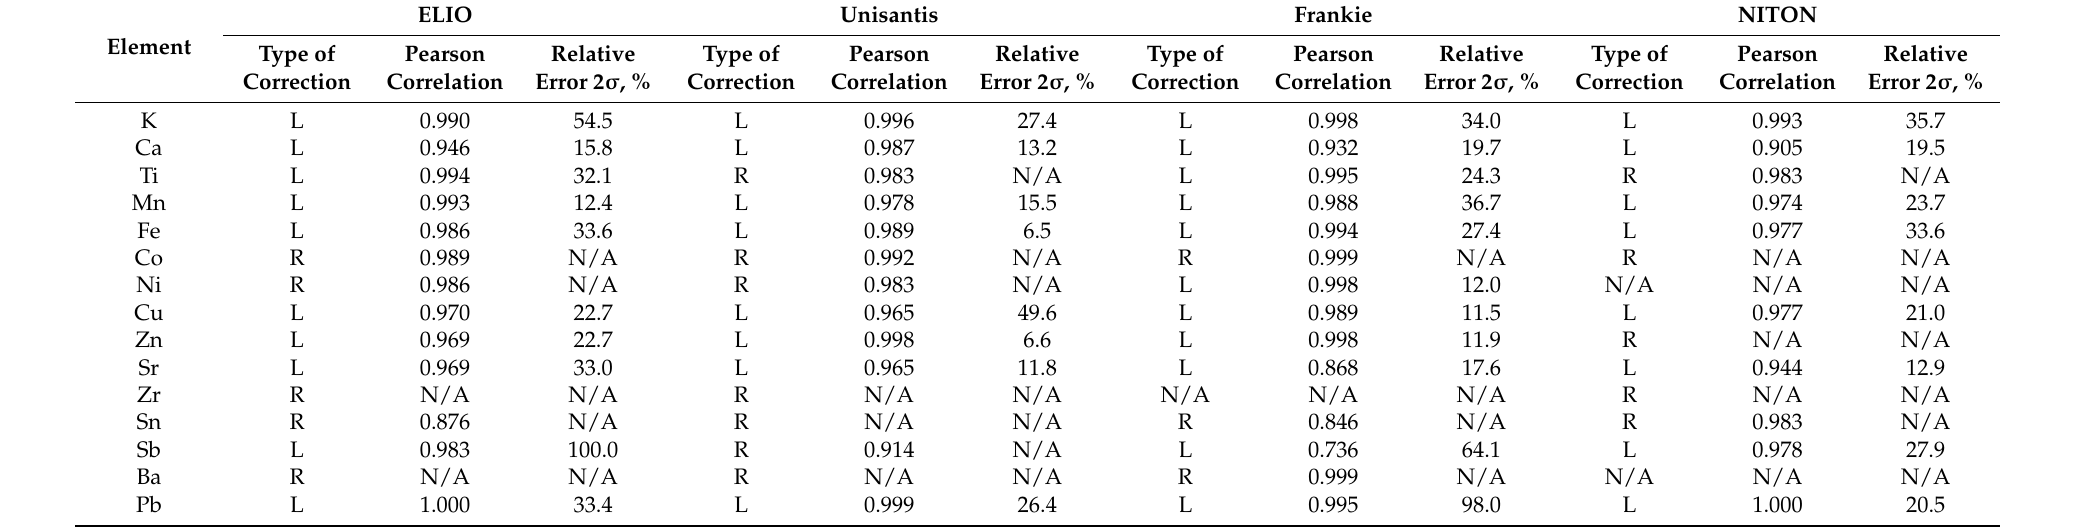
Table 3. Corrections applied and the errors of the measurement (2 σ values). L: linear regression coefficients. R: ratio coefficients. N/A: not applicable. Correlation coefficients are calculated between corrected and nominal